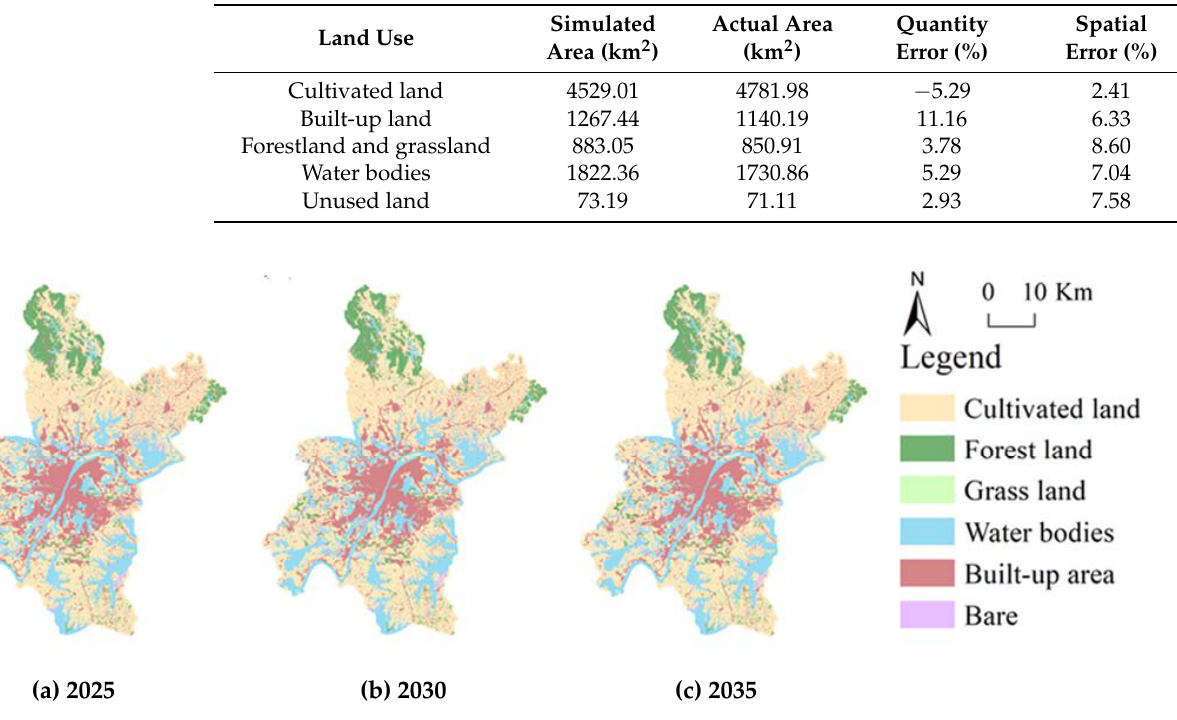
Figure 9. Land-cover predictions for ( a ) 2025, ( b ) 2030, and ( c ) 2035 using the CA-Markov model.